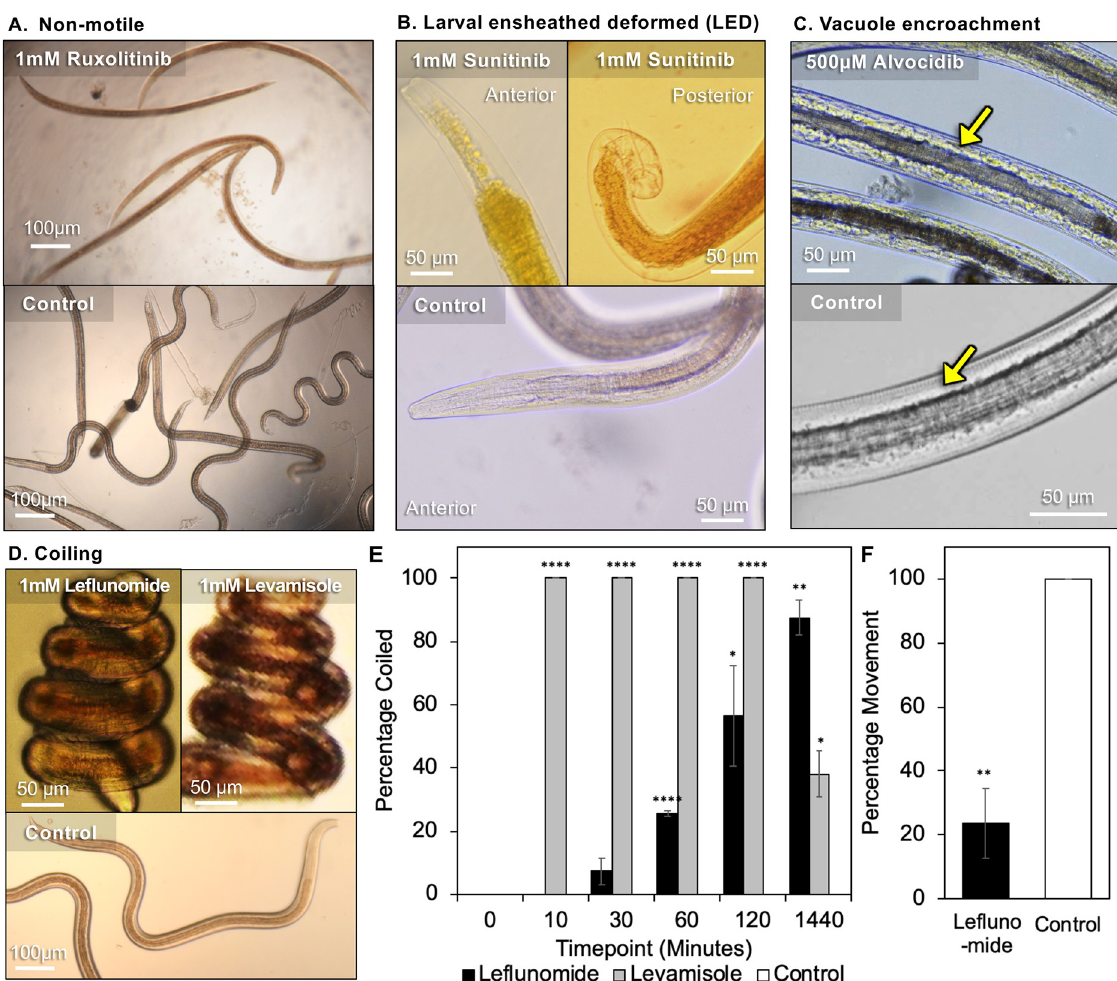
Fig 4. Observed phenotypes among tested inhibitors in A . suum L3 larvae. ( A ) Non-motile—Alvocidib, Ruxolitinib, Staurosporine, CID 1067700, Taltobulin, Combretastatin. ( B ) Larvae ensheathed deformed (LED); showing detached cuticle and deformed anterior and posterior ends of the larvae induced by Sunitinib treatment (also, replicated with Tofacitinib, Camptothecin, Leflunomide, Staurosporine). ( C ) Somatic vacuoles (white arrow). ( D ) Coiling (Leflunomide). ( E ) The proportion of larvae with the coiled phenotype over time. Controls were all zero values. ( F ) Motility comparison after 90 minutes of larvae exposure to Leflunomide. For E and F, asterisks represent the results of two-tailed T tests with unequal variance ( � P < 0.05, �� P < 0.01, ��� P < 0.001, ��� P <